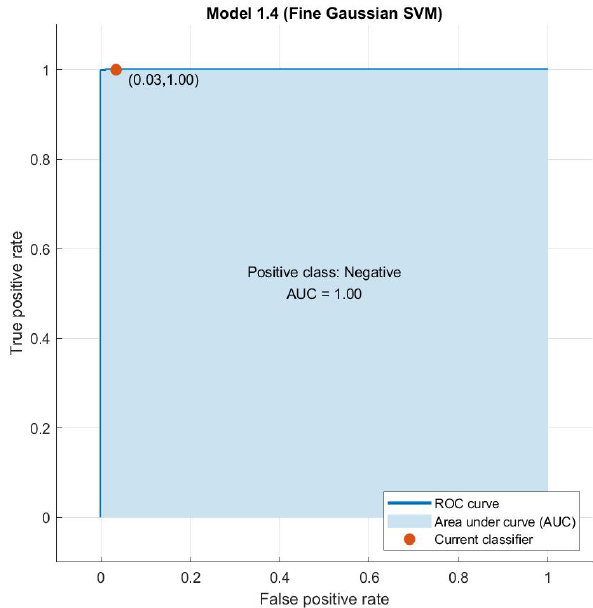
Figure 9. ROC of Fine gaussian